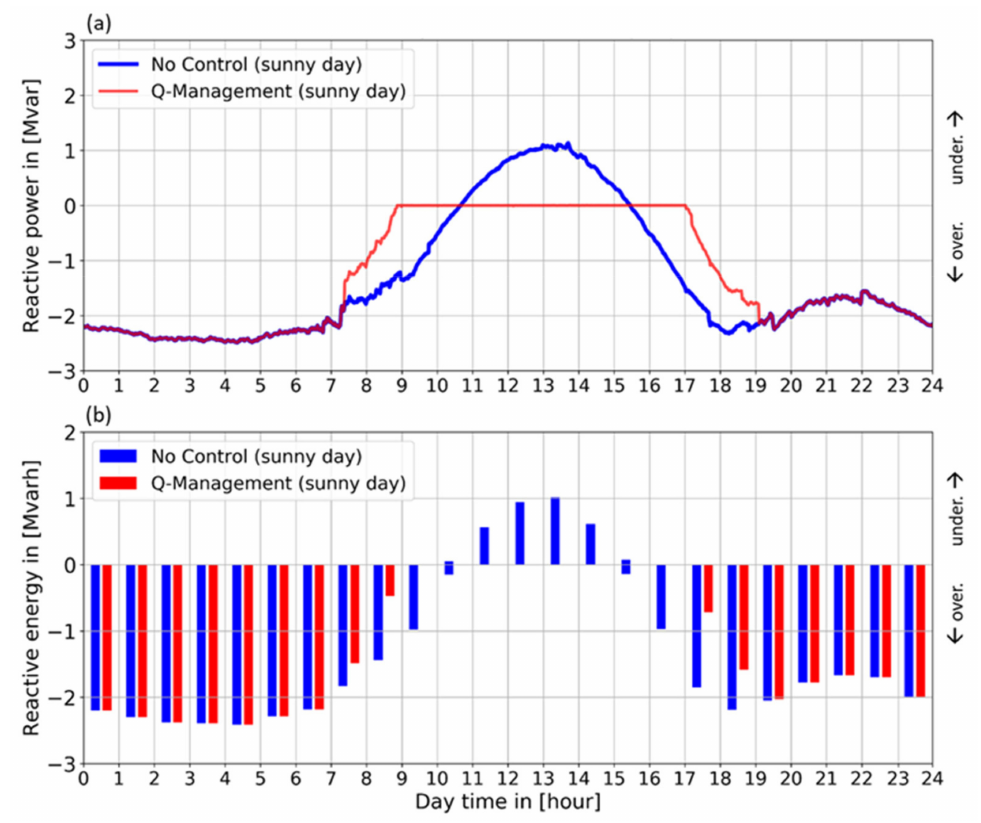
Figure 8. Reactive power exchange at 110 kV-NCP ( a ) and the resulting reactive energy exchange ( b ) for the investigated sunny summer day (with 1 min control